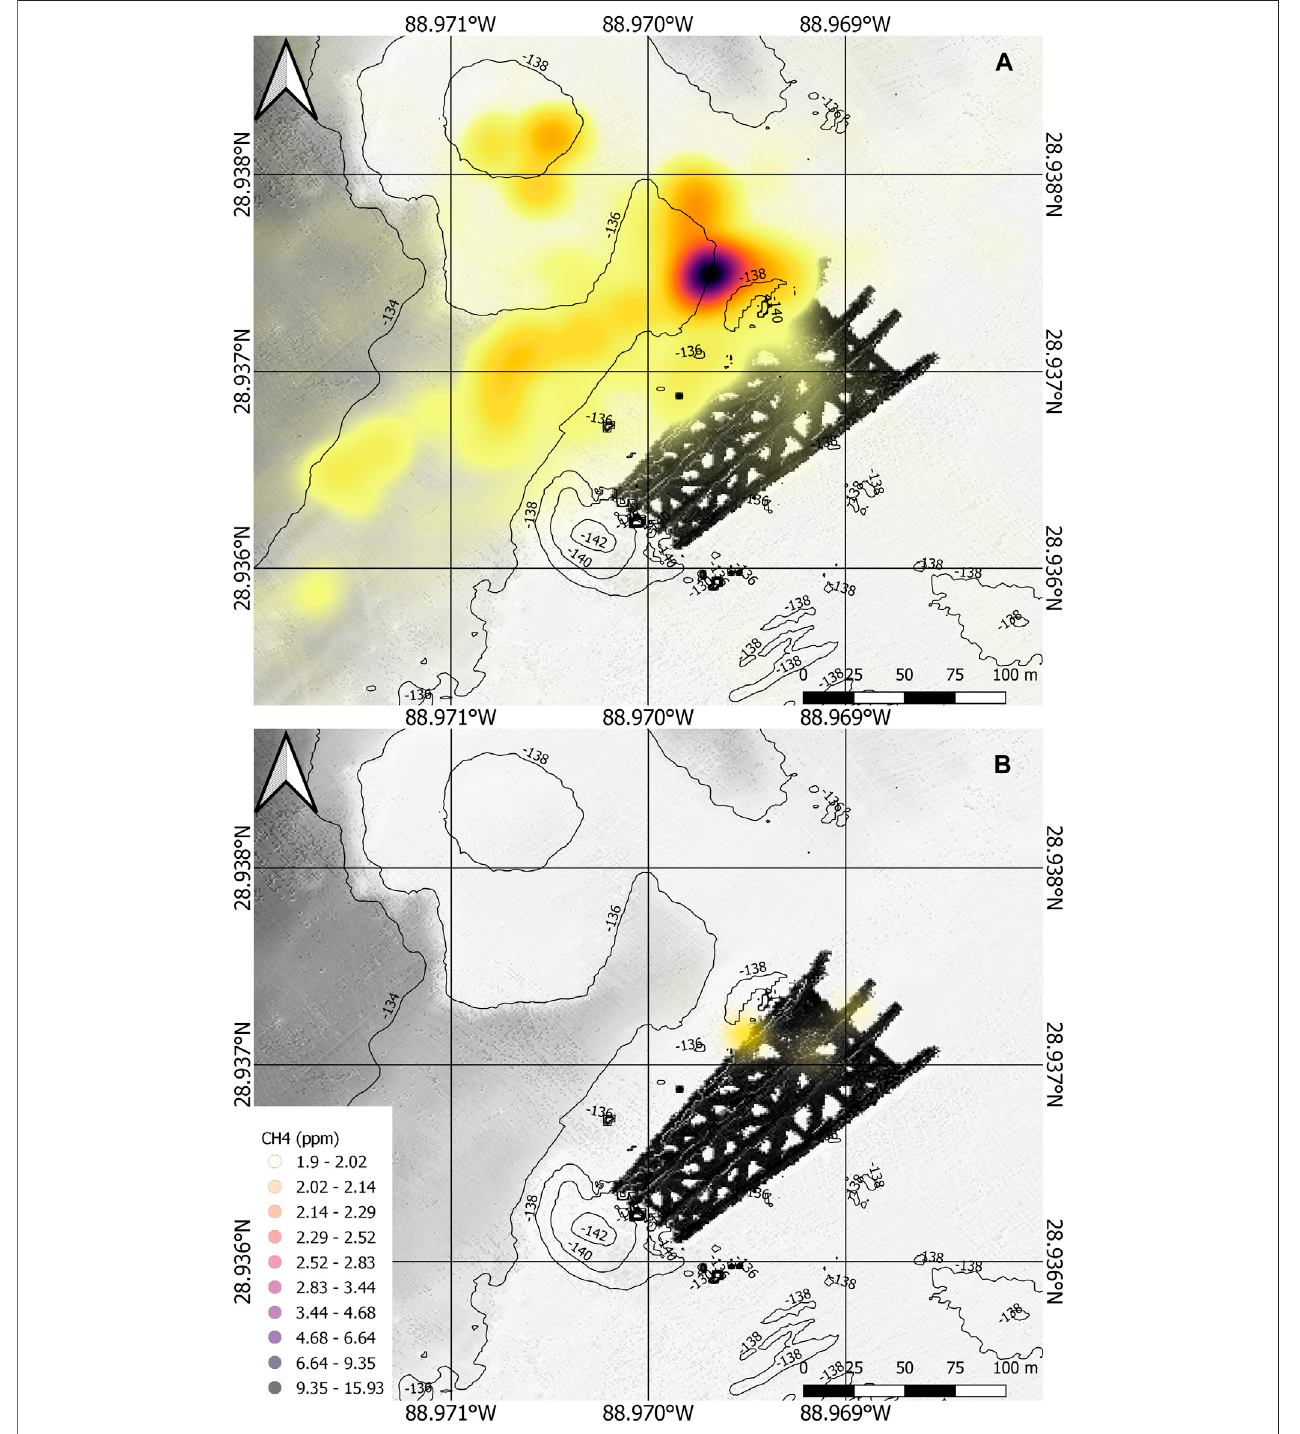
FIGURE10| Heatmapsofmethaneconcentrations:CRDSreadingsrecorded9 maboveseasurfaceovertheMC20site. (Aupper) 2018,beforeoilcontainment; (B lower) 2021, after oil containment.